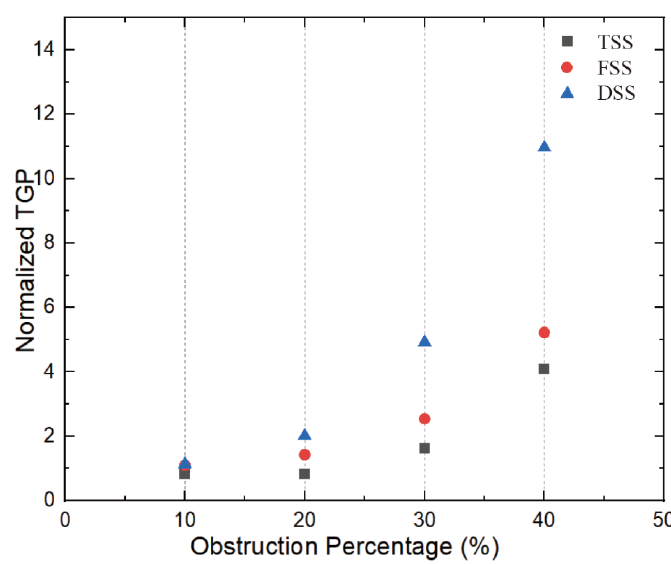
Figure 11. Pressure drops in the direction of blood flow ( t = 0.2 s).